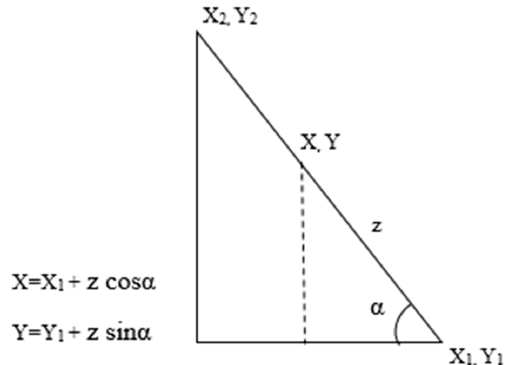
Figure 3. Interpolation algorithm for geotagged words.